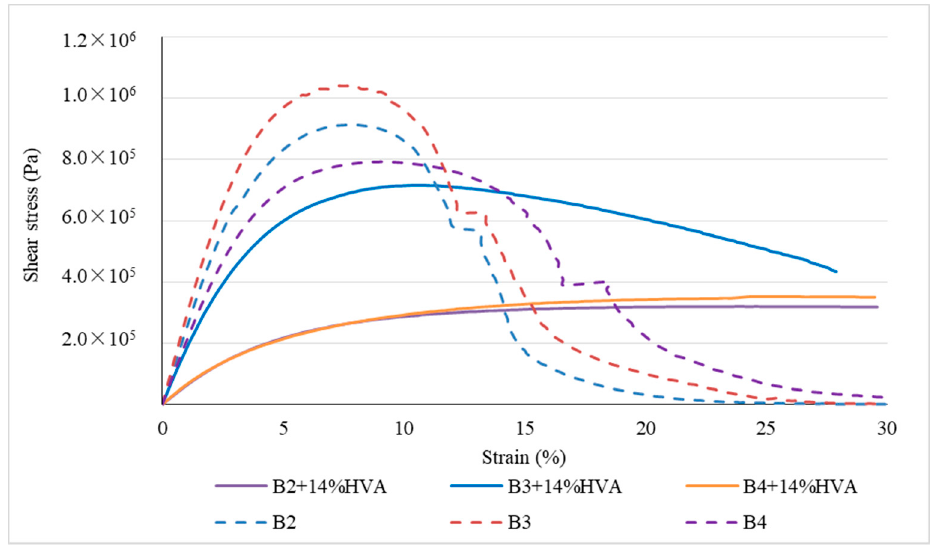
Figure 9. Stress-strain curves of three kinds of matrix asphalt and high-viscosity asphalt with 14% HVA.